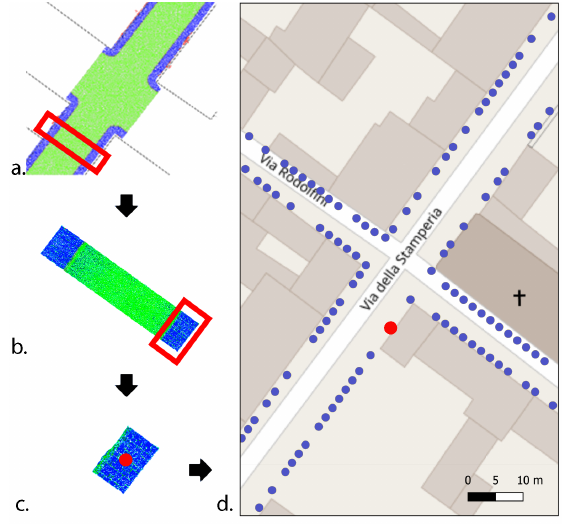
Figure 4. Example of vectorization workflow for a sidewalk seg- ment. Selection of a segment of road on the point cloud (a), selec- tion of the sidewalk cluster of points (b), computation of cluster center (c), and visualization of the cluster center (i.e. node) over- lapped to a city map